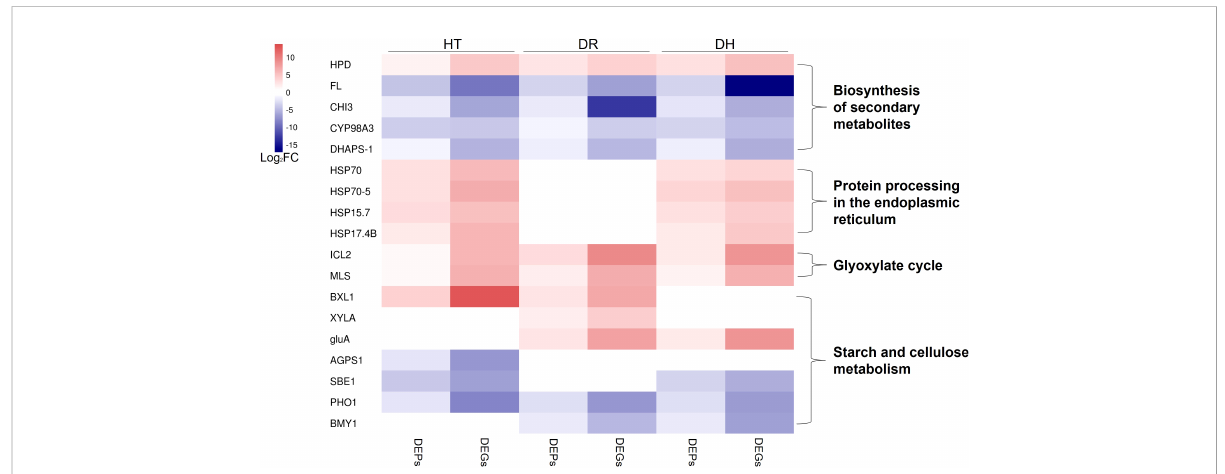
FIGURE 11 Heatmap of the fold change of DEGs/DEPs (FDR <0.05, simultaneously) in processes of biosynthesis of secondary metabolites, endoplasmic reticulum processing of proteins, glyoxylate cycle, and starch and cellulose metabolism under HT, DR, and DH stresses. The color scale ranges from navy (downregulated DEGs/DEPs), white (no DEGs/DEPs) to fi rebrick (upregulated DEGs/DEPs). HT, heat stress; DR, drought stress; DH, drought and heat